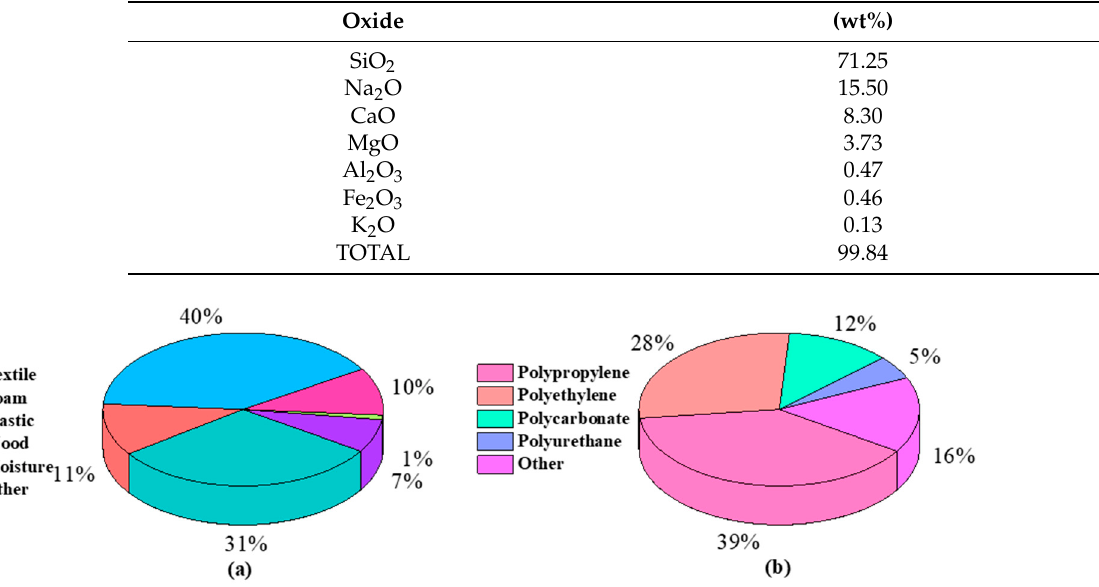
Table 2. CHNSO analysis of ASR.